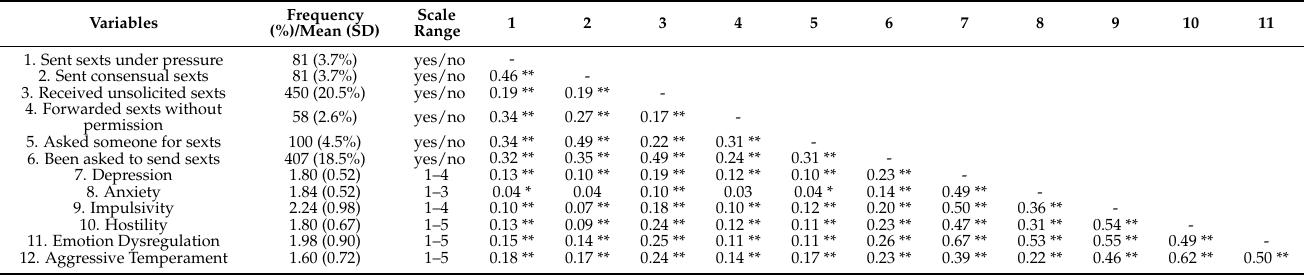
Table 1. Variable frequencies, means, standard deviations, and bivariate correlations.